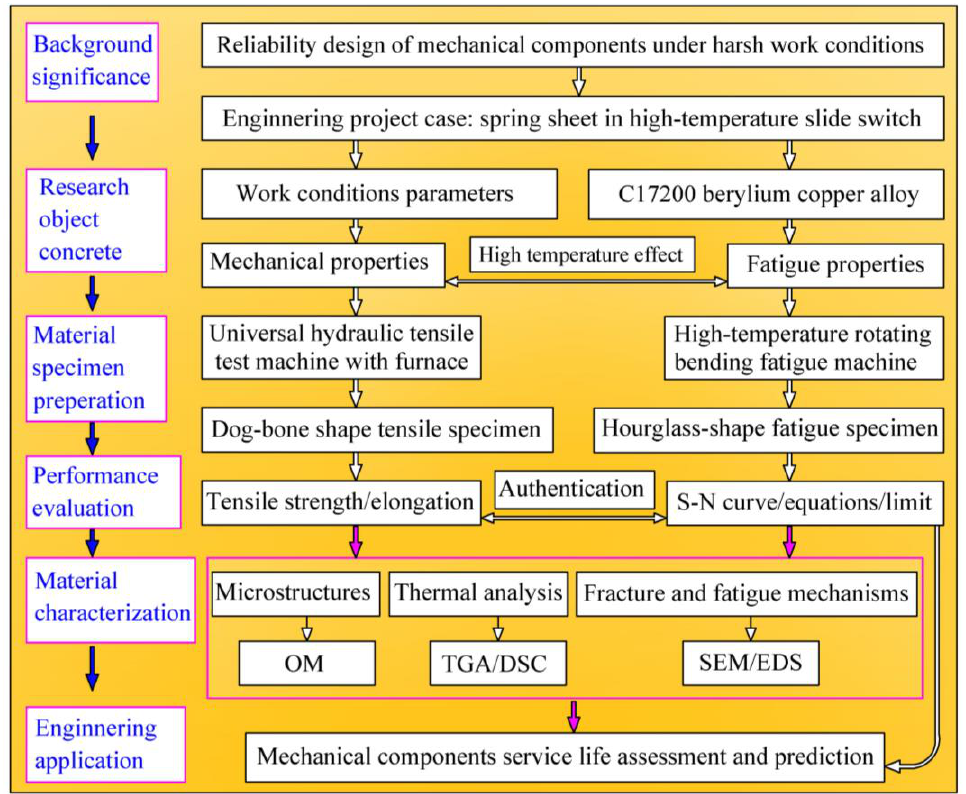
Figure 2. Research idea flow and contents arrangement.